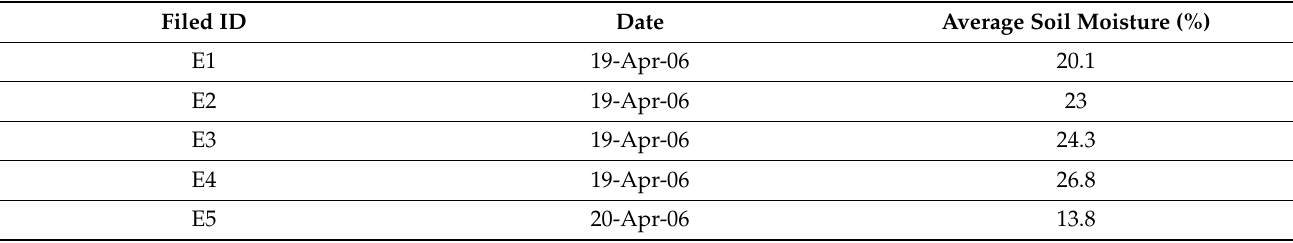
Figure 4. Pauli images of the field dataset. ( a ) E1, E2, E3, and E4 are dated 19 April 2006, and ( b ) E5 is dated 20 April 2006. Table 4. Soil moisture data